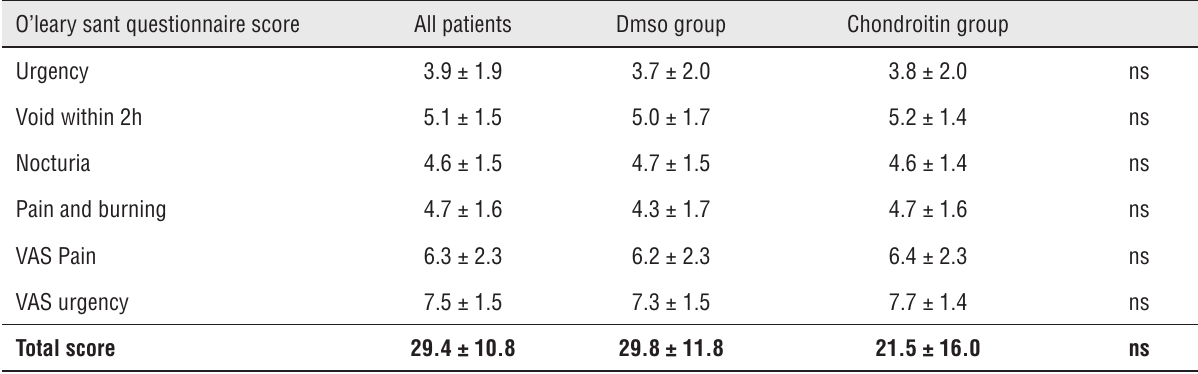
Table 2 - Baseline patient characteristics. O’leary sant questionnaire score All